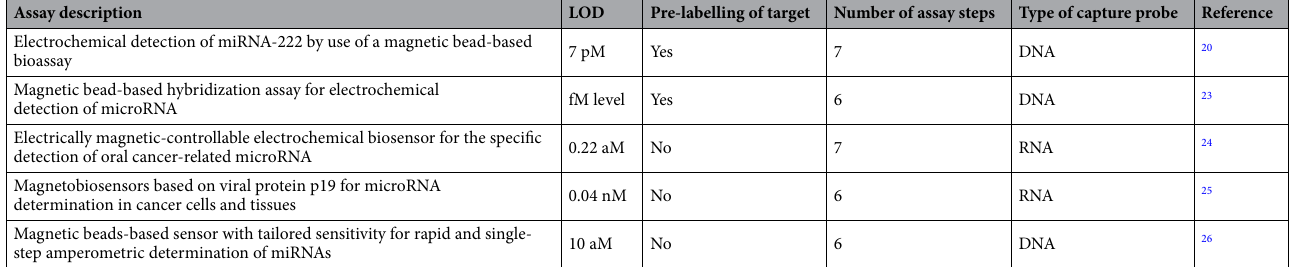
Table 1. Examples of magnetic beads-based electrochemical detection methodologies for miRNA